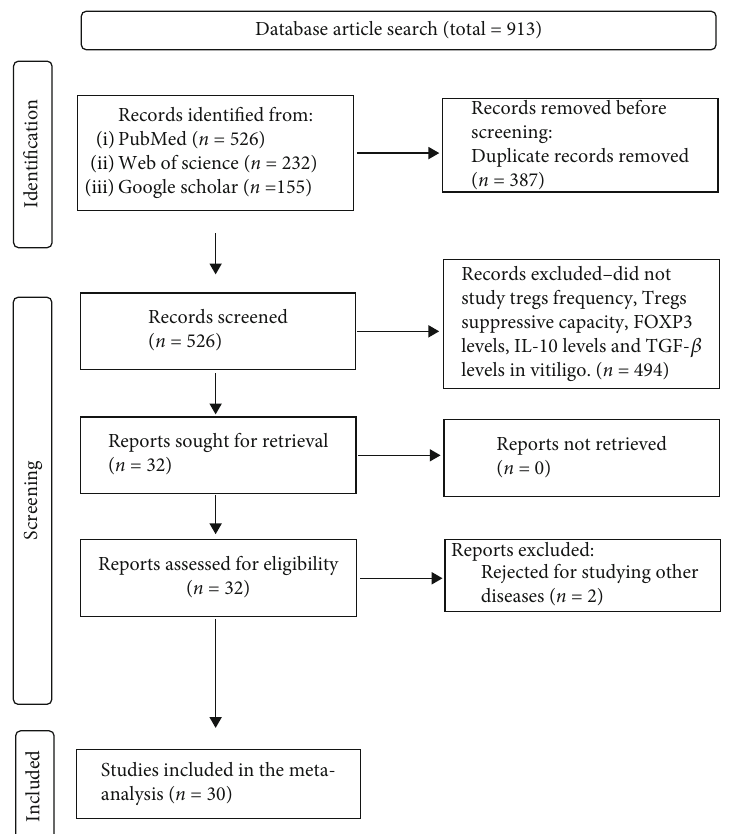
Figure 1: The fl ow chart of study selection for the meta-analysis. A total of 526 studies from PubMed, 232 studies from Web of Sciences, and 155 studies from Google Scholar databases were retrieved and processed for initial screening. After screening for the titles and abstracts, 387 duplicate records and 496 studies which did not study Tregs ’ frequency, Tregs ’ suppressive capacity, FOXP3 levels, IL-10 levels, and TGF- β levels in vitiligo were excluded. Finally, 30 studies consisting of total 1223 vitiligo patients and 1109 controls were included for the